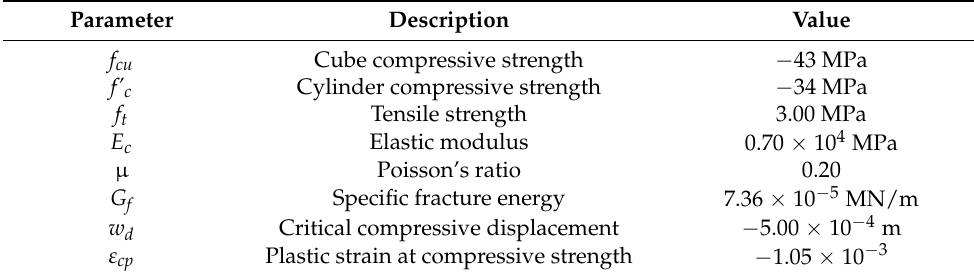
Table 8. Key input parameters of the geopolymeric